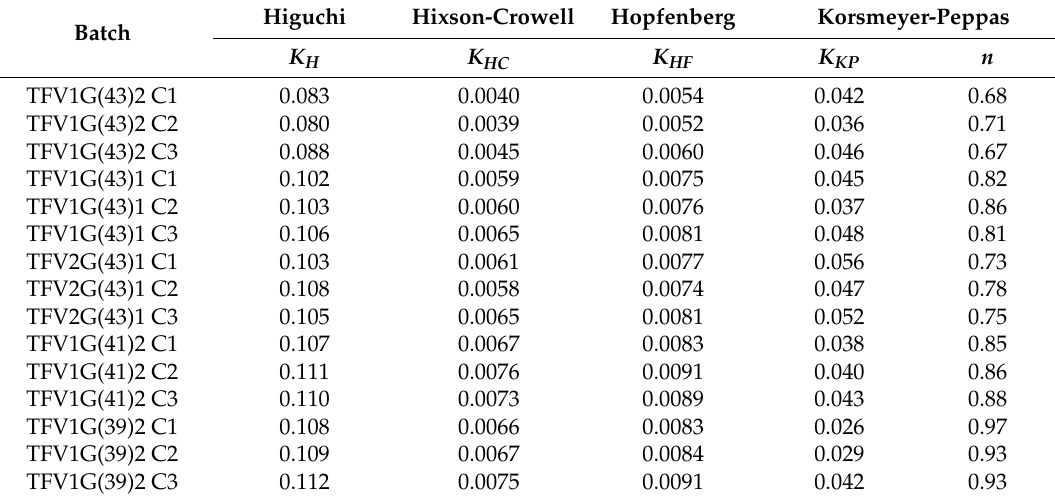
Table 5. TFV release kinetics from the different batches showing the kinetic constants for the models with the best